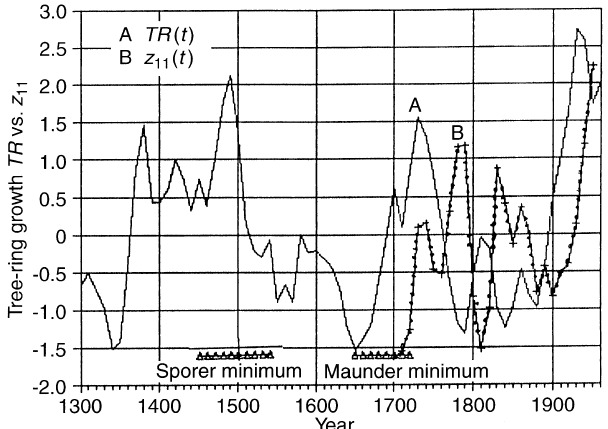
Fig. 21. Long-term tree-rings and solar activity